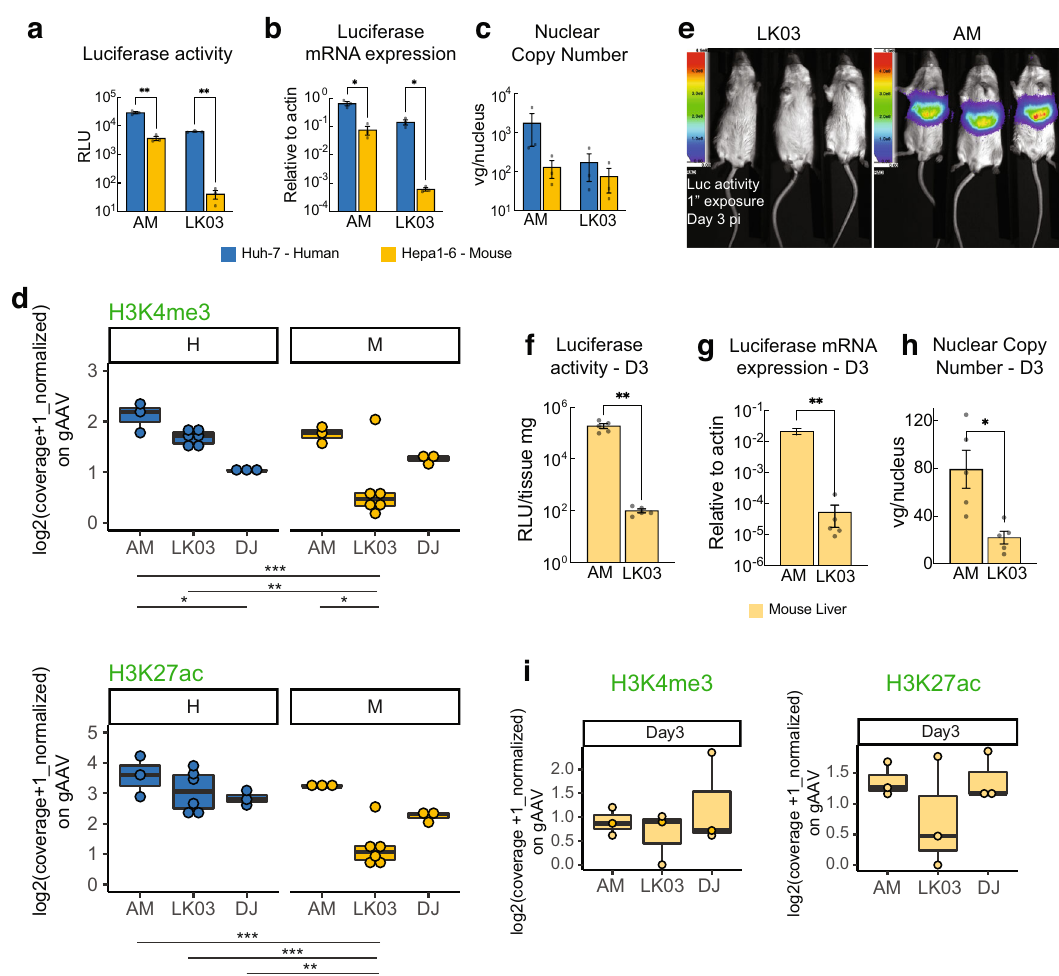
Fig. 3 | A single glycine amino acid insertion in AAV-LK03 (AAV-AM) enables mouse ef fi cient transduction, including active-related epigenetic pro fi le in vitro and in vivo. a In vitro 48h transduction luciferase activity assay. b Luciferase transcript quanti fi cation. c Nuclear copy number quanti fi cation in Huh7humanandHepa1-6mousecellstransducedwithAAV-LK03andAAV-AMby qPCR. d Cut&Tag boxplots of normalized coverage on AAV genome of active- related histone marks in vitro. e In vivo luciferase activity assay 3 days post intra- venous injection of AAV-LK03 and AAV-AM. f Liver tissue luciferase assay. g Luciferasetranscriptquanti fi cation. h NuclearcopynumberqPCRquanti fi cation 3 days post intravenous vector injection. i Cut&Tag boxplots of normalized cov- erage on AAV genome of active-related histone marks in vivo. Statistics were